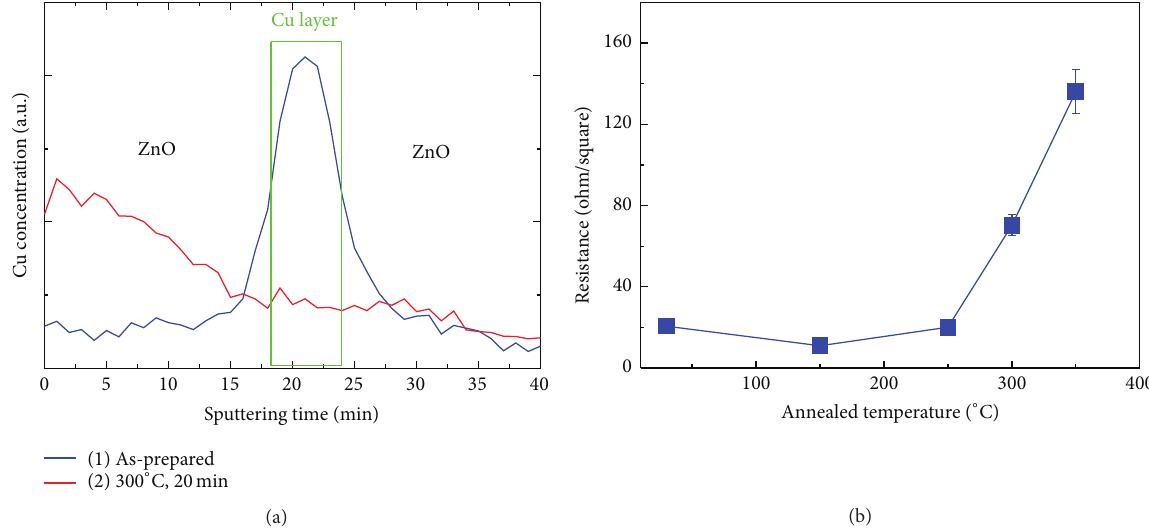
Figure 4: (a) Depth profile of Cu ion in the ZCZ multilayer as-prepared and after annealing at 300 ∘ C for 20 min and (b) dependence of resistance of ZCZ on the postannealing